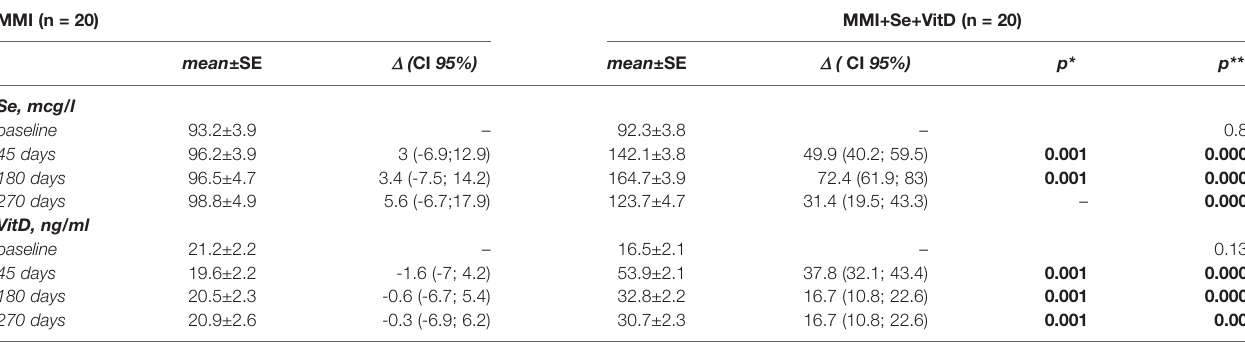
TABLE 2 | Temporal variation of mean vitamin D (VitD) and selenium (Se) levels in the two groups of treatment at different temporal